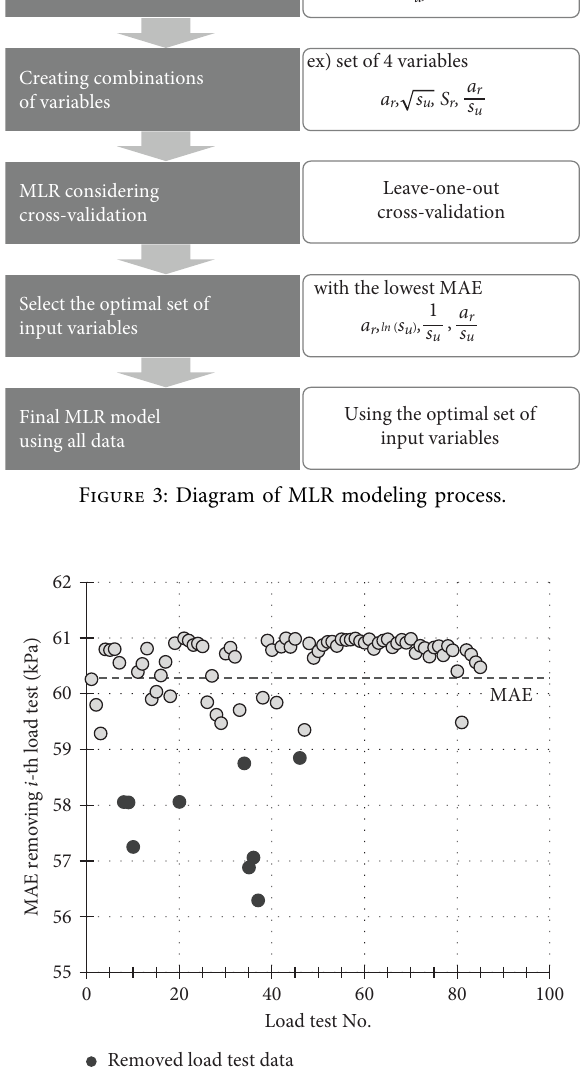
Figure 4: MAE change due to the removal of each load